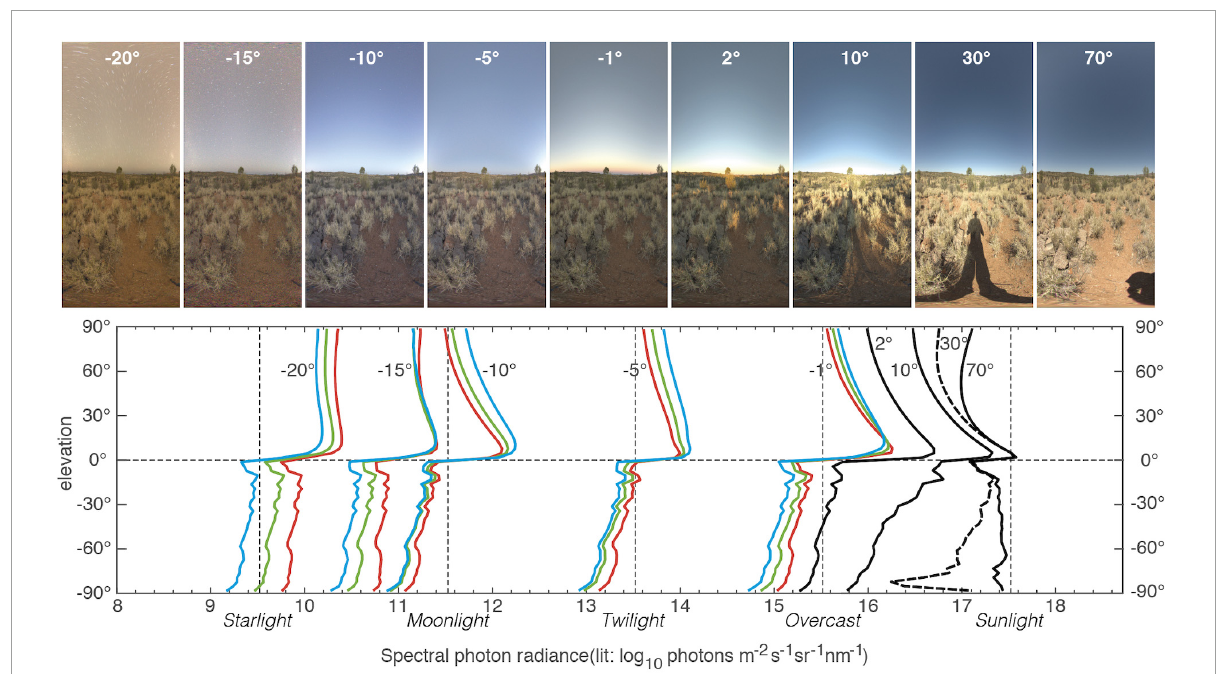
FIGURE5 Vertical light gradients at a single scene in arid country south of Alice Springs, Northern Territory, Australia, sampled at different times, both day and night (17–18 October 2017). Images of the scene are shown above for each of the solar elevations plotted in the graph below. Absolute radiances are plotted with the sun at different elevation angles from –20 ◦ (below the horizon) at night to 70 ◦ above the horizon during the day. Night-time measurements are plotted with separate curves for red, green, and blue to show the shifts in spectral balance. To avoid clutter, daytime measurements are not divided into separate curves for different spectral bands (Full daytime graphs are provided in Supplementary Figure S3 ). The curve for 30 ◦ is shown as a dashed line for clarity. Measurements were taken at new moon to avoid influence of moonlight at night. The location was selected to be entirely free of detectable light pollution. All displayed measurements are of the antisolar hemisphere. The solar hemisphere was also recorded and found to be similar, but at daytime, angles ± 20 ◦ of the sun’s elevation are noticeably brighter. The labels, Starlight , Moonlight , Twilight , Overcast , and Sunlight are not related to the displayed data, but provided by the analysis software as guides for typical radiances. All measurements provided in the figure were recorded under completely clear